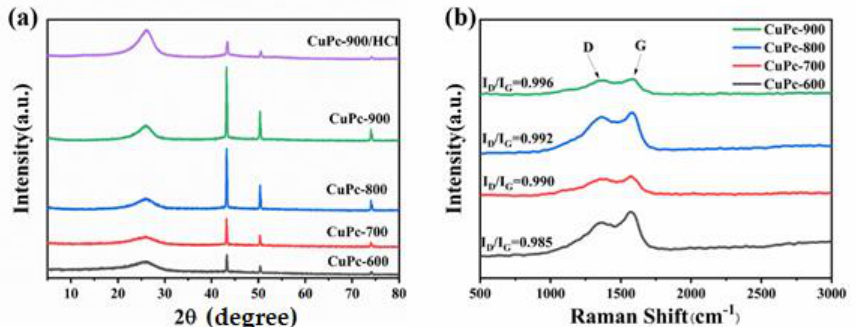
Figure 4. XRD patterns of CuPc-600, CuPc-700, CuPc-800, CuPc-900, and CuPc-900/HCl ( a ) and Raman patterns of CuPc-600, CuPc-700, CuPc-800, and CuPc-900 ( b ). The complex permittivity ( ε r = ε (cid:48) − j ε (cid:48)(cid:48) ) and the complex permeability ( µ r = µ (cid:48) − j µ (cid:48)(cid:48)